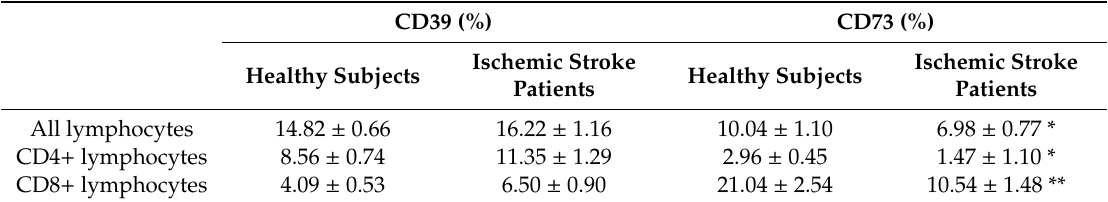
Table 3. Sizes of di ff erent lymphocytic populations expressing CD39 and CD73 from healthy subjects (n = 20) and ischemic stroke patients (n = 21). Population size is given in the mean percentage ± SEM. Non-parametric two-tailed Mann–Whitney U-test was used to test for significance. * p < 0.05; ** p <